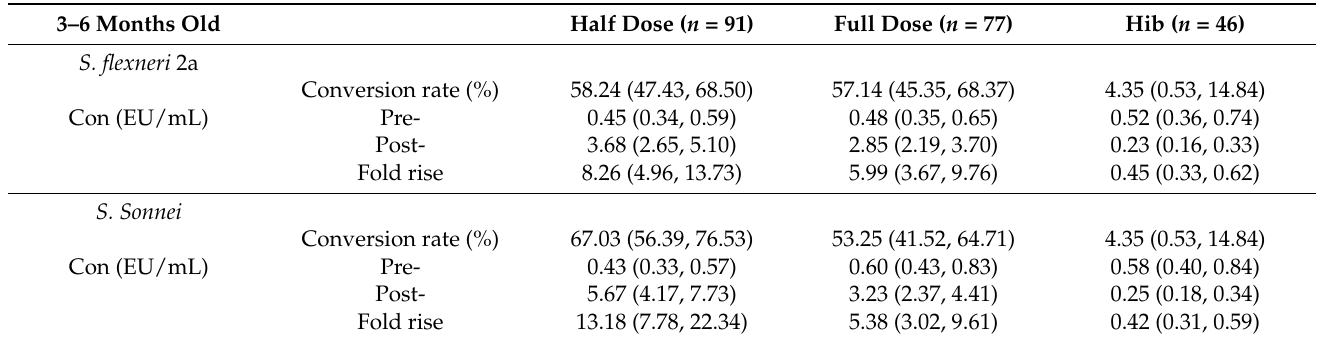
Table 2. Serum anti ‐ LPS IgG levels in children aged 3–6 months old vaccinated with a half or full dose of the trial vaccine ZF0901.